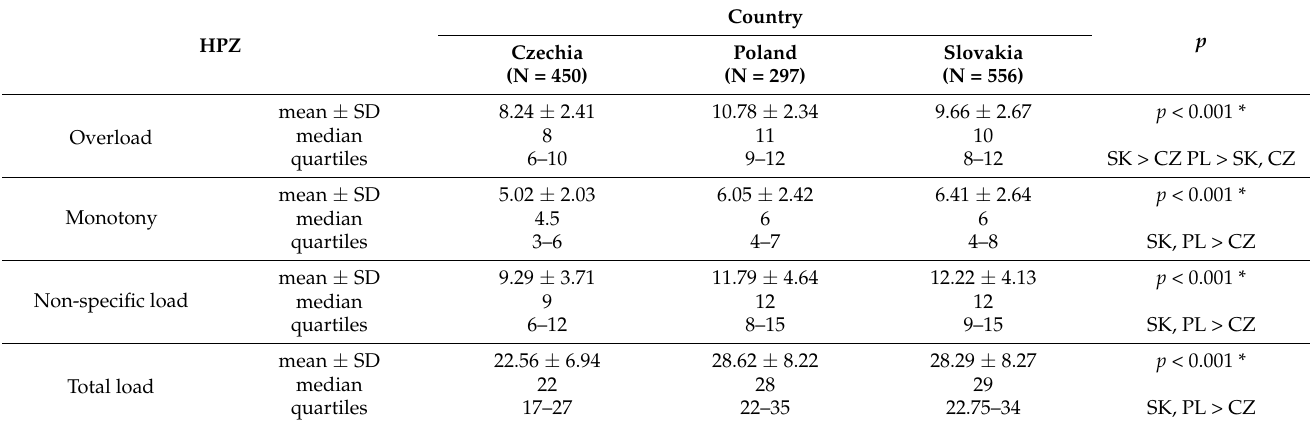
Table 3. Group assessment of Meister questionnaire in nurses by